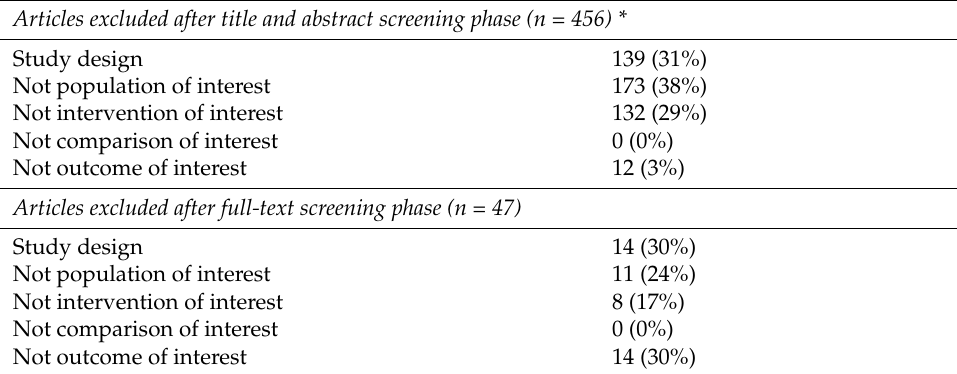
Table 2. Reasons for article exclusion by the present systematic